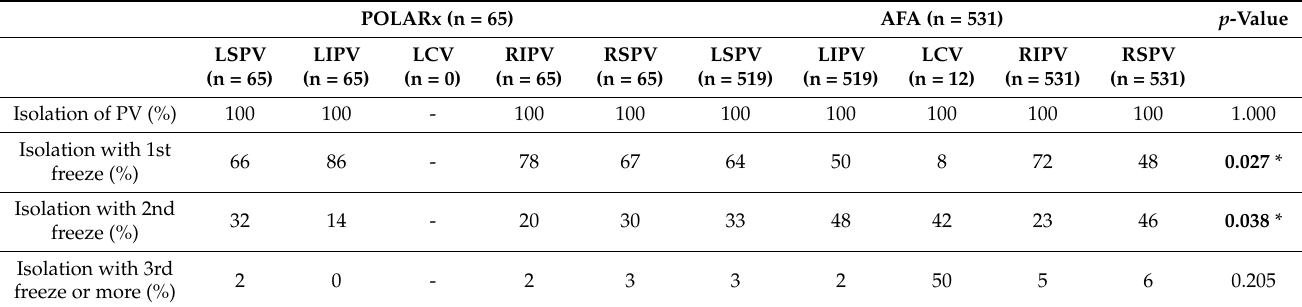
Table 4. Acute success rates per freeze cycle.